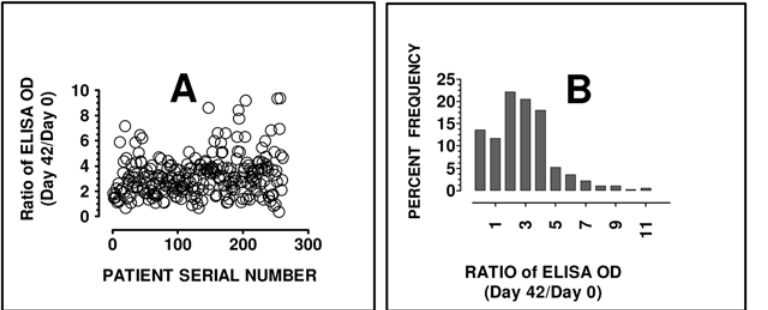
Fig 3. Fold increase in post-infection serum anti-peptide IgG. Sera obtained at diagnosis and 42 days later were tested by ELISA using GLURP, MSP3 and HRPII synthetic peptides as micro titer well-bound antigen coat. For each study participant, the ELISA ODs were added to produce a summative ELISA OD. A. The ratio of respective summative ELISA OD for serum collected on day 42 and day 0 (y-axis) was plotted against serial number of study subject (x – axis). ELISA OD represents IgG level while the ratio of the ELISA units for the serum drawn on the 2 days (Day 42/day 0) represents fold-increase in anti-peptide IgG. B. Histogram of the ratio (ELISA absorbance for day 42 serum/ ELISA absorbance for day 0 serum). OD: optical density or absorbance.